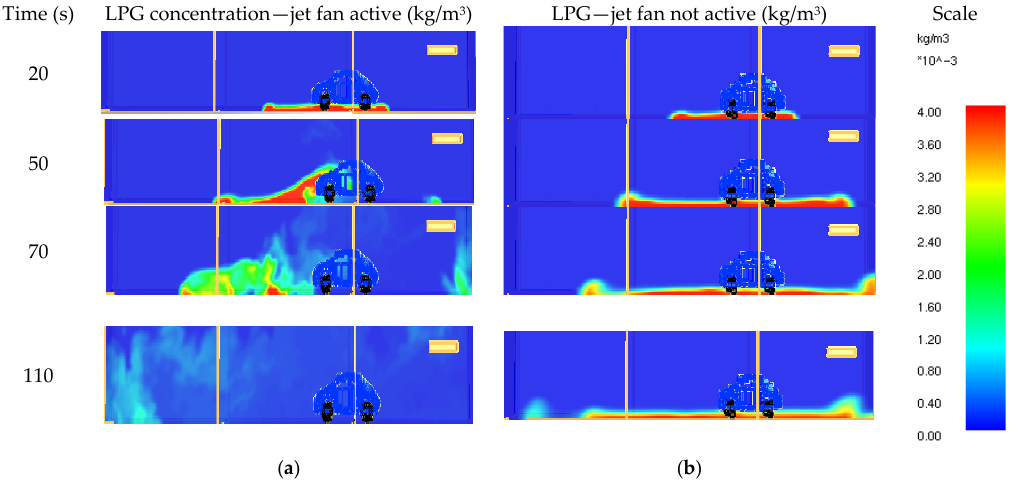
Figure 14. CFD results—LPG gas concentration: ( a ) jet ventilation active and ( b ) jet ventilation not active.